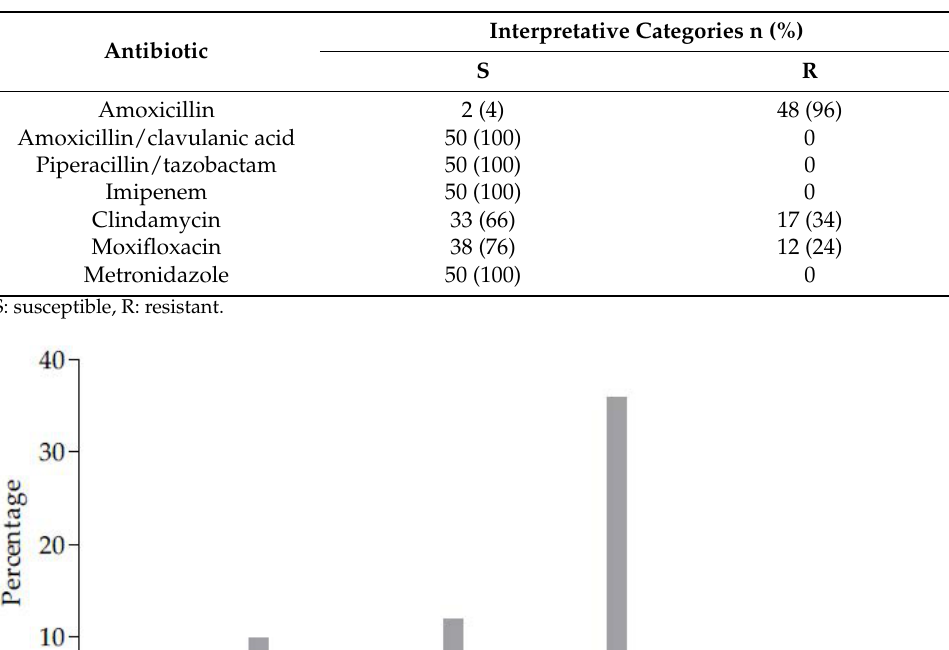
Table 2. Antibiotic susceptibilities of 50 isolates of Prevotella melaninogenica (according to recommen- dations of EUCAST/CASFM 2019 [21].